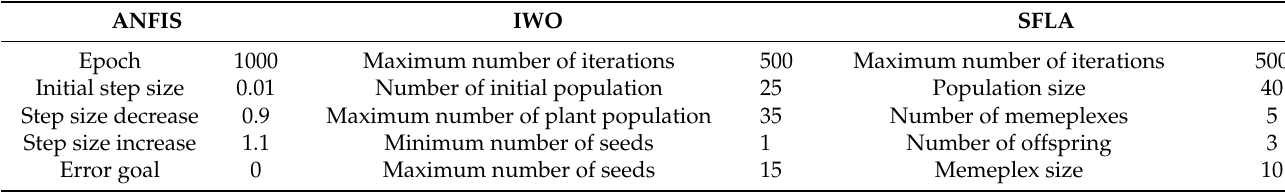
Figure 4. Flowchart of the ANFIS, hybrid ANFIS-SFLA, and ANFIS-IWO models. Table 3. Parameter settings for ANFIS, IWO, and